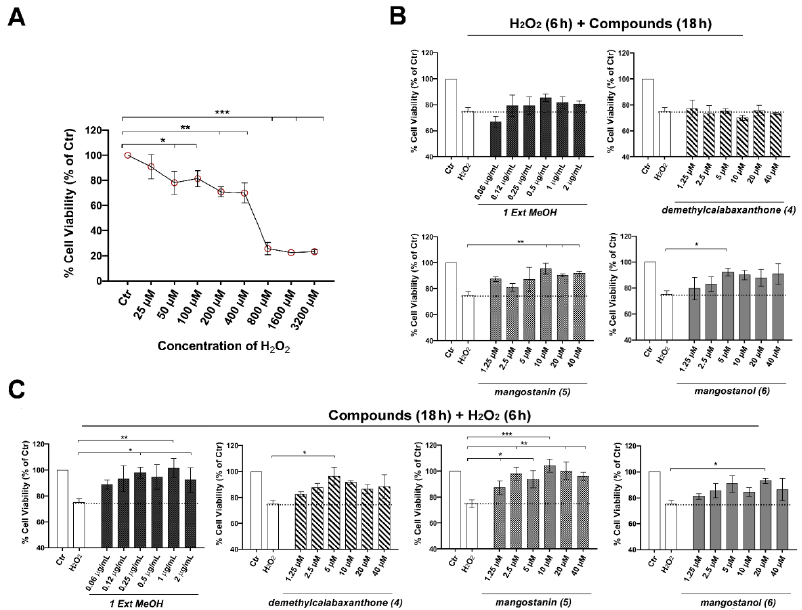
Figure 4. Mangostanin rescued and prevented H 2 O 2 -induced cytotoxicity in HaCaT cells. ( A ) Cells exposed to H 2 O 2 (0 – 3200 µM) for 6 h before MTT assay. Results of three independent experiments performed in triplicate are expressed as means ± SD and reported as % vs. the untreated control (ANOVA, * p <0.05, ** p < 0.01, *** p < 0.001 vs. control). ( B ) Cells were grown in the presence of H 2 O 2 for 6 h, before treatment with methanol extract of G. mangostana arils (0 – 2 µg/mL) or com- pounds demethylcalabaxanthone ( 4 ), mangostanin ( 5 ), mangostanol ( 6 ) at the indicated concentra- tions (0 – 40 µM) for 18 h. Results of independent experiments performed in triplicate are expressed as means ± SD and reported as % vs. the untreated control (ANOVA, * p < 0.05, ** p < 0.01 vs. con- trol). ( C ) Keratinocytes were cultured in the presence of methanol extract of G. mangostana arils (0 – 2 µg/mL) or compounds 4 – 6 (0 – 40 µM) for 18 h, before treatment with H 2 O 2 for 6 h. Results of independent experiments performed in triplicate are expressed as means ± SD and reported as % vs. the untreated control (ANOVA, * p <0.05, ** p < 0.01, *** p < 0.001 vs. control). 3.4. Mangostanin Prevents the Generation of Intracellular Reactive Oxygen Species (ROS) Keratinocytes were pretreated with mangosteen methanol extract or mangostanin for 18 h before adding 200 µM of H 2 O 2 for 6 h to verify the protective effect on intracellular ROS generation. Production of ROS was evaluated by 2′,7′ -dichlorofluorescein (DCF) measurement and monitored using flow cytometry. As demonstrated by an incremented